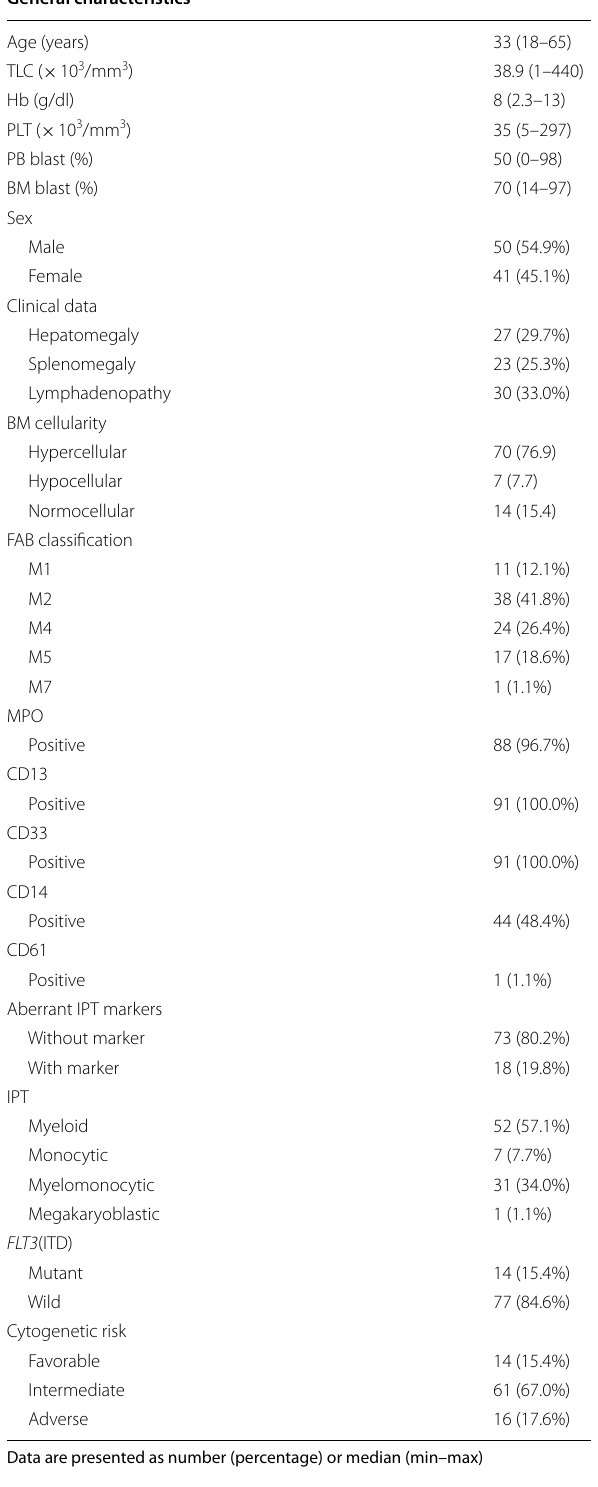
Table 1 Clinical and laboratory characteristics of the AML